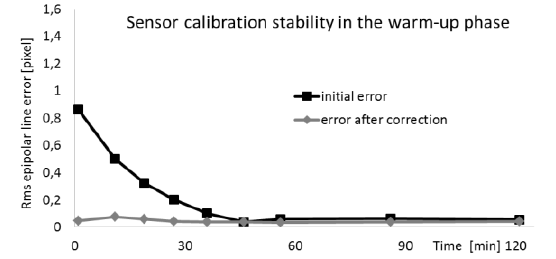
Figure 9: Rms epipolar line error of scanner HS over two hours from switch on, 2011/04/06, measuring object: plane